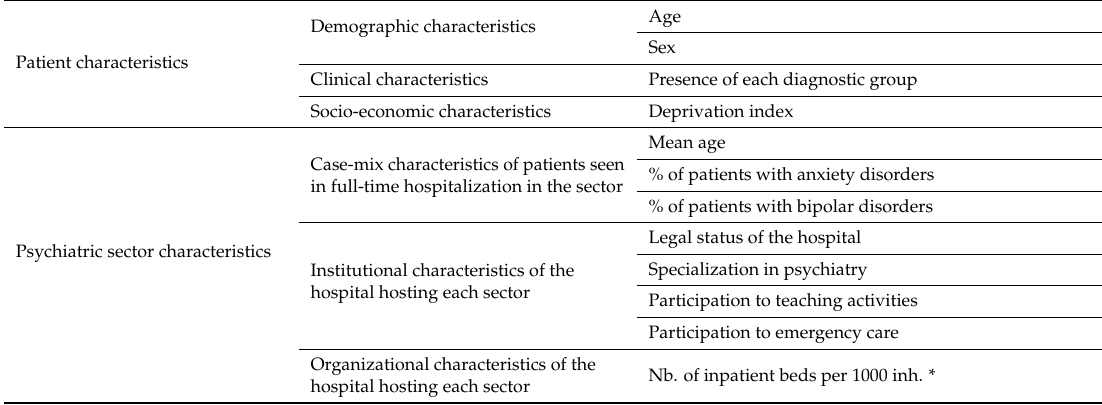
Table 3. Explanatory variables introduced in the multivariate analysis in addition to the level of development of